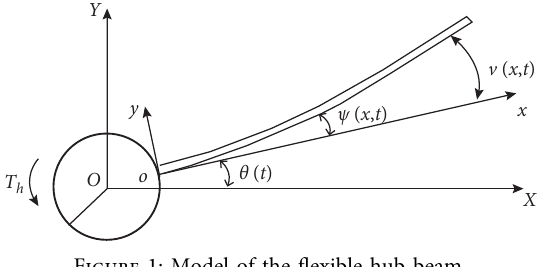
Figure 1: Model of the flexible